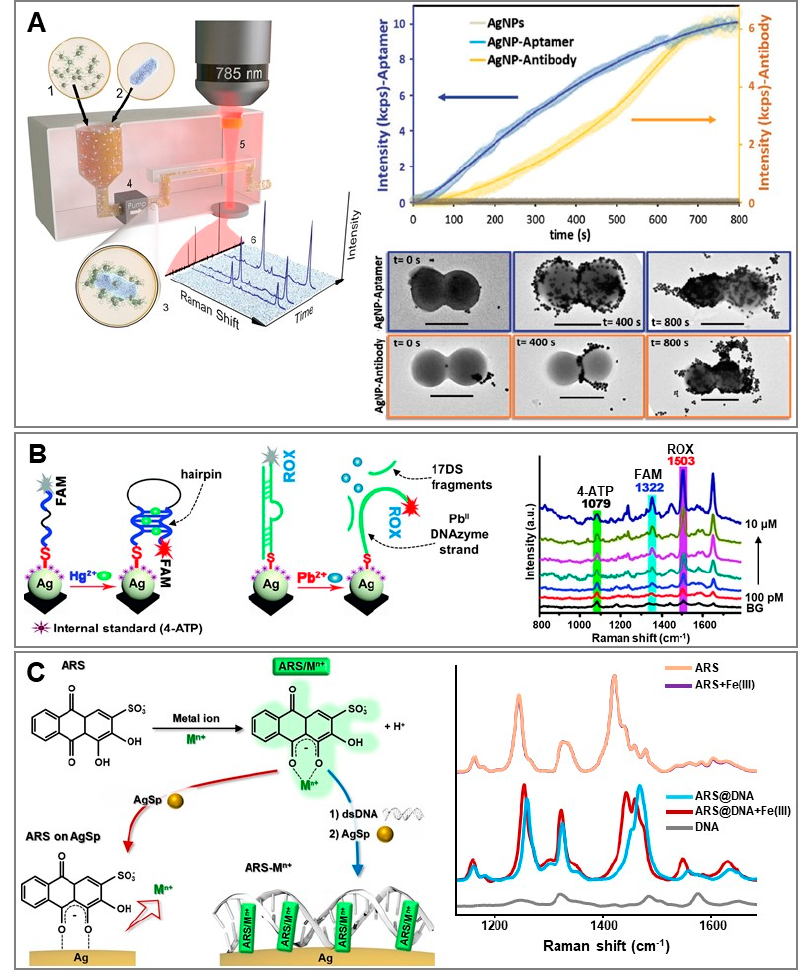
Figure 4. ( A ) Left: Conceptual view of microorganism optical detection system (MODS): SERS-encoded silver nanoparticles labelled with different SERS codes and functionalized with bacteria-selective antibodies are mixed with the biofluid. Selective nanoparticle accumulation occurs on the targeted microorganism membrane. Online SERS interrogation is then performed by flowing the sample into a millifluidic channel. Adapted with permission from [61]. Copyright 2016, Springer Nature. Right: Comparison of the time-dependent SERS intensity of aptamer- vs. antibody-SERS encoded nanoparticles (code = MBA) in serum solutions spiked with ca. 7 × 10 3 CFUs per mL of S. aureus (top). TEM images of S. aureus as a function of the incubation time with the SERS-encoded particles (bottom). Scale bar: 1 µ m. Adapted with permission from [60]. Copyright 2016, Wiley-VCH. ( B ) Outline of the multiplex SERS detection of Hg(II) and Pb(II) on silver nanoparticle film and SERS spectra of equimolar Pb(II) and Hg(II) mixtures at increasing metal ion concentrations (from 100 pM to 10 μ M). Background (BG) stands for distilled water. Adapted with permission from [63]. Copyright 2018, Royal Society of Chemistry. ( C ). Description of the interaction of Alizarin Red S/metal ion complexes (ARS/M n+ ) on AgSp with and without dsDNA. SERS spectra of ARS, ARS + Fe(III), ARS + dsDNA, ARS + dsDNA + Fe(III) and dsDNA in PBS 0.1 M (pH 5.5) in the 1200–1570 cm –1 spectral region. Final concentrations in the sample: ARS = 1.75 μ M, dsDNA = 48 nM, Fe(III) = 3.5 μ M. Adapted with permission from [64]. Copyright 2019, American Chemical Society.